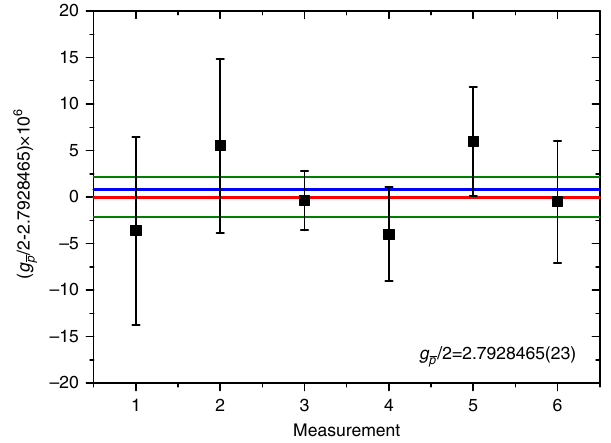
Figure 4 | Experimental result. Results of the six g -factor measurements carried out during CERN’s 2015/2016 accelerator shutdown between the 20 February 2016 and 5 March 2016. Based on this set of measurements we extract ( g /2) ¼ 2.7928465(23), as indicated by the red horizonal line. (cid:2) p The green lines show the 95% confidence level error, the blue line represents the currently accepted value of the proton g -factor g p /2 ¼ 2.792847350(9) (ref. 26). The error bars of the individual measurements are based on the uncertainties of the individual frequency measurements, which are dominated by the random walk in the magnetron